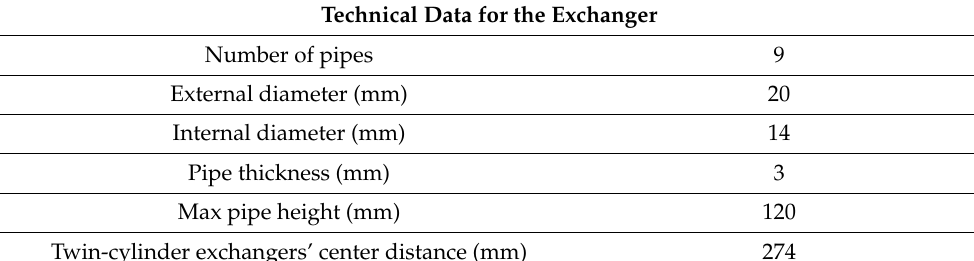
Figure 6. Hot side heat exchanger. Table 3. Characteristics of the Nazgul heat exchanger.